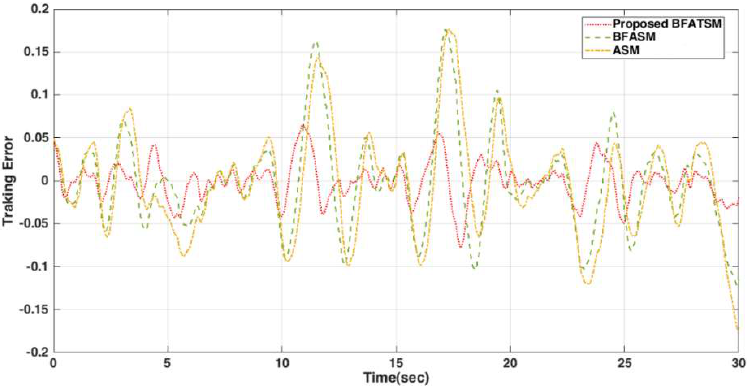
Figure 5. Tracking errors between ASM [1] and BFATSM [2] controllers.